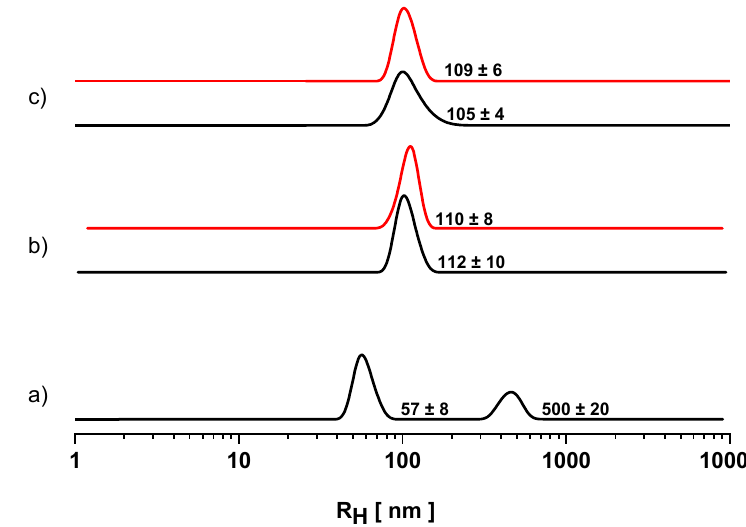
Figure 2. Hydrodynamic radius distributions for water-in-oil (W / O) emulsions measured at time zero (t 0 ), that is, immediately after emulsification (black lines), and one hour later (red lines). ( a ) Water / dodecane POPE-POPG emulsions; ( b ) water / dodecane POPE-POPG-Span80 emulsions; ( c ) water / squalene POPE-POPG emulsions.